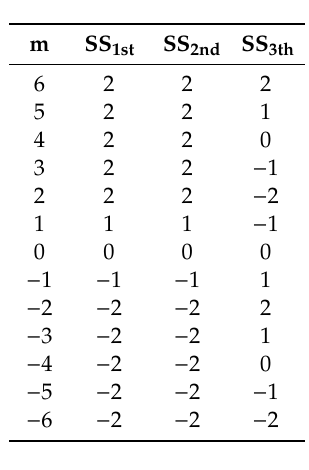
Table 3. Module 3LNPC Converter Switch